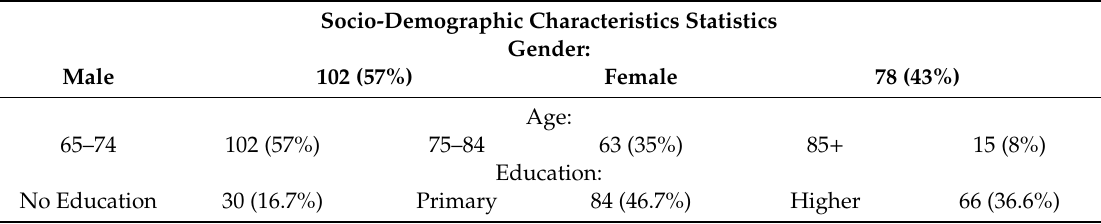
Table 2. Descriptive statistics for sociodemographic characteristics ( n =